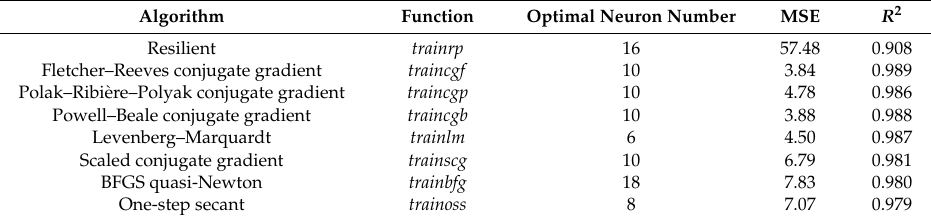
Table 1. Backpropagation training algorithms. MSE, mean squared error.